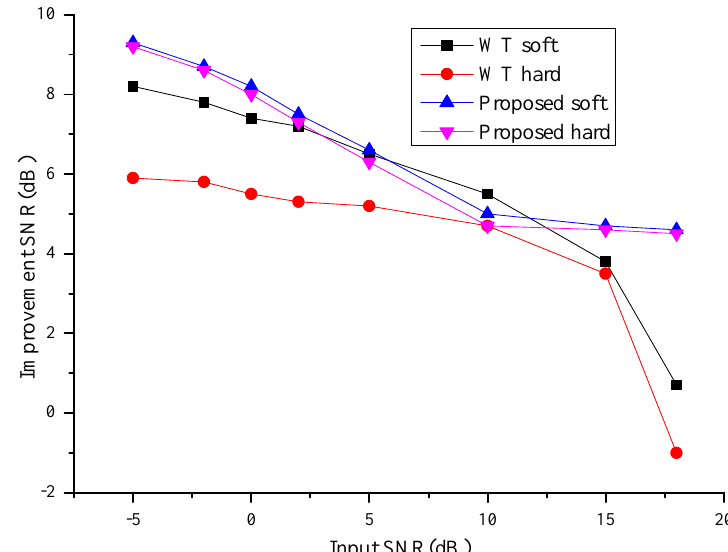
Figure 9. WT and proposed method output SNR improvement versus different input SNRs for the first 4096 samples of the MIT-BIH record number 100.